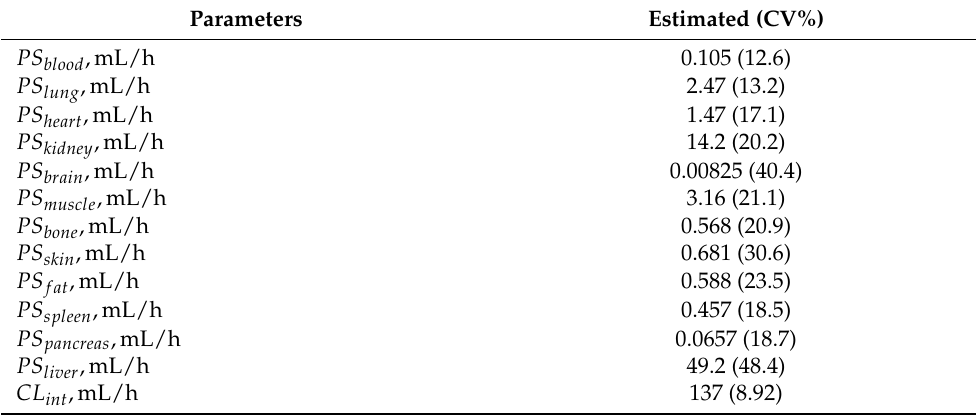
Table 3. PBPK model estimated parameter